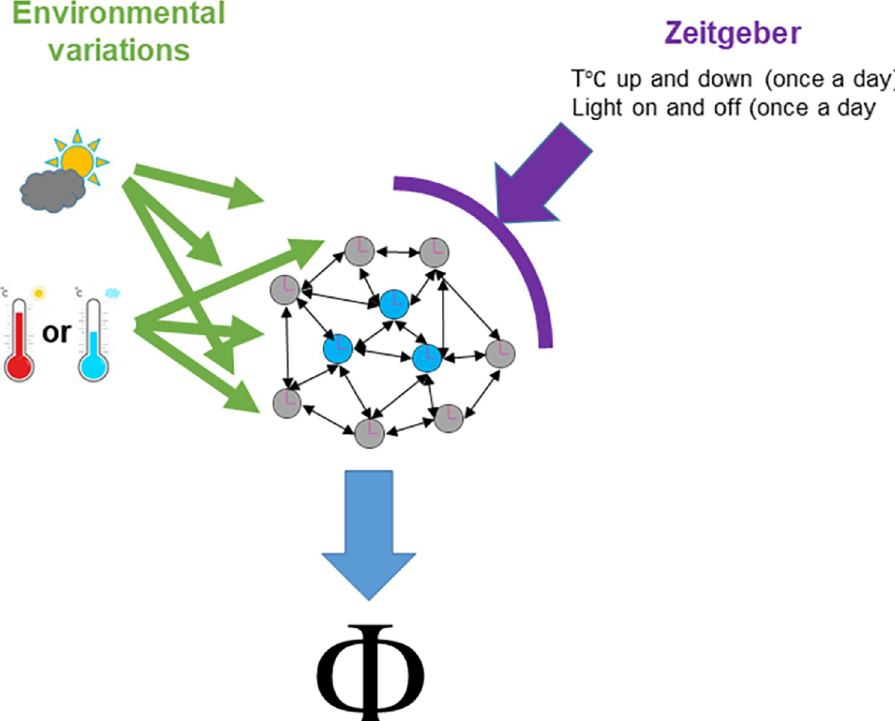
Fig 6. Environmental cues act as Zeitgeber and set behavioral activity Phase. The molecular clock in brain clock neurons is entrained by light and temperature. However, these two environmental inputs vary on a day to day basis (e.g., cloudy versus sunny days), and animals change their activity at different times of day in response to the ambient environmental condition. How does the circadian system distinguish between an input that entrains the circadian clock (Zeitgeber) and one that after integration by the clock system, sets the daily activity phase? Here, we demonstrate that the EO determines the behavioral evening peak ( F ) in the presence of light and 25˚C, while the circadian clock is entrained with a 25˚C:16˚C temperature cycle. In contrast, the MO determines the morning peak in constant darkness and 25˚C, during the same temperature cycle. We present a model explaining how the environment and the circadian clock shape locomotor activity. On one hand, the on/up and off/down environmental changes that happen once a day entrain the molecular clocks in the system (purple arrow). On the other hand, different environmental input such as light (quality and intensity) and temperature (different levels), here represented by green arrows, are perceived by different oscillators in different manners. Depending on the time of day (the molecular clock status of the system), this will lead to a modification of the network balance and a dominancy of one or several oscillators (blue clocks vs grey ones), resulting in a behavioral activity phase ( F ) according to the internal timing and the current condition. Therefore, to biologically demonstrate this model, we fixed a Zeitgeber (in this study TC 25˚C-16˚C) and tested how light (here presence/absence) modifies the balance. From this basis, we can now apply more subtle modifications such as the intensity or the quality of light to change the phase of the behavior and use this to understand the principles underlying neuronal network